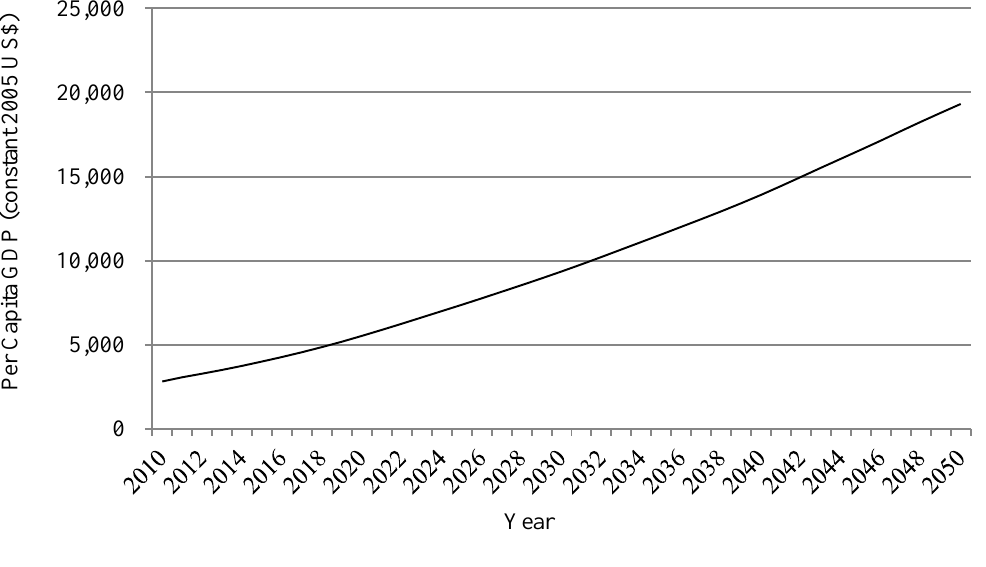
Figure 6. Annual Chinese per capita GDP